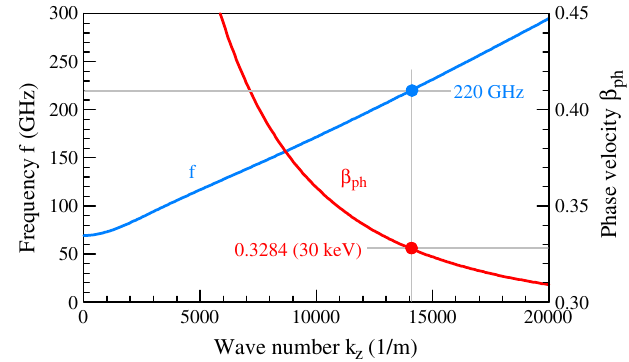
FIG. 2. (Color) Dispersion curves: frequency f and normalized vs axial wave number k phase velocity (cid:1) ph mode. It is seen that at 220 GHz ( k (cid:3) 0 : 4475 mm ), a 30-keV electron beam synchronizes 2 (cid:3)=k z with the